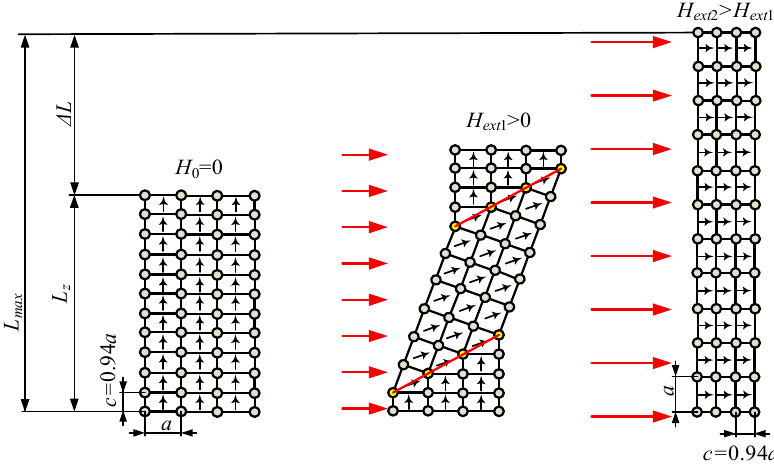
Figure 1. Deformation of a crystal lattice in a magnetic field, where a and c are the lengths of a single martensite cell ( c = 0.94 a ).